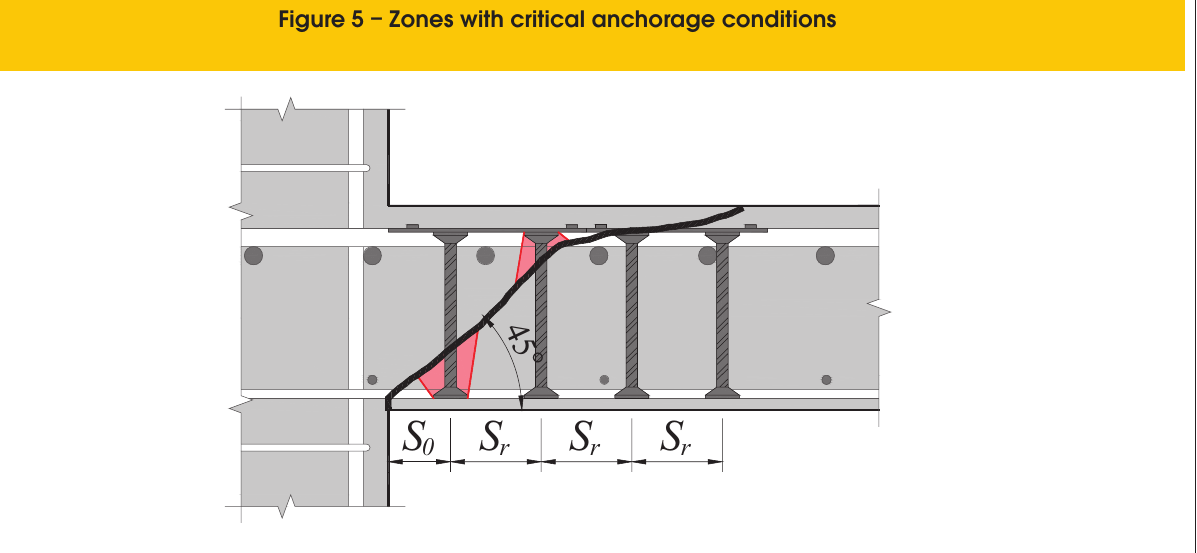
Figure 5 – Zones with critical anchorage